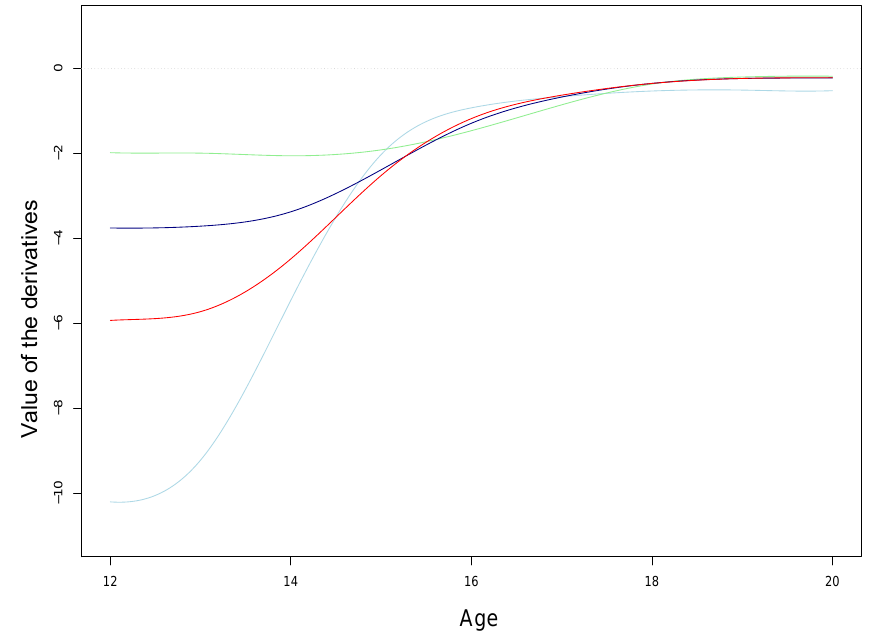
Figure A4. Clusters’ centres of the derivatives of the progressions curves. Computed with the univariate funHDDC algorithm. Clusters mostly differ on the value of the derivatives at a young age and all converge to 0 at 20 years